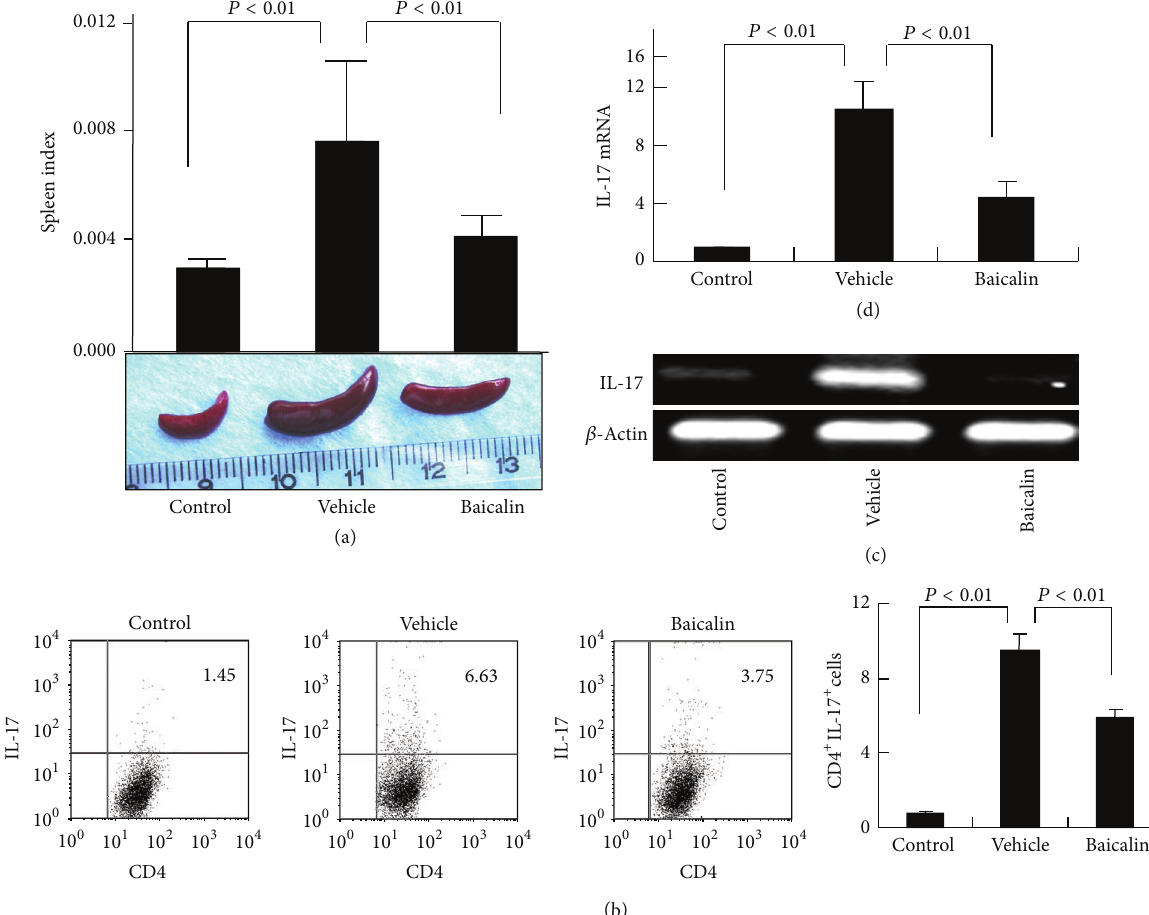
Figure 3: Baicalin inhibits splenic Th17 cell expansion in vivo . Adjuvant-induced arthritis mice were injected intraperitoneally daily with 100mg/kg Baicalin or phosphate-buffered saline (vehicle control) between postimmunization days 14 to 21. (a) Spleen index of control and adjuvant-induced arthritis mice with or without Baicalin treatment ( 𝑛 = 6 for each group). Spleen photographs are shown in the lower panels (b). Isolated splenocytes were stained and sorted by flow cytometry first for CD4 + T cells. IL-17 + T cells were analyzed in the CD4 + gate (left). The percentage of dual positive CD4 + IL-17 + cells among the gated CD4 + T cell fraction in each treatment group is shown on the right ( 𝑛 = 6 for each group). (c) IL-17 gene expression in joint tissues was analyzed by RT-PCR. These experiments were performed three times with similar results. (d) IL-17 gene expression in joint tissues was analyzed by real-time RT-PCR ( 𝑛 = 6 for each